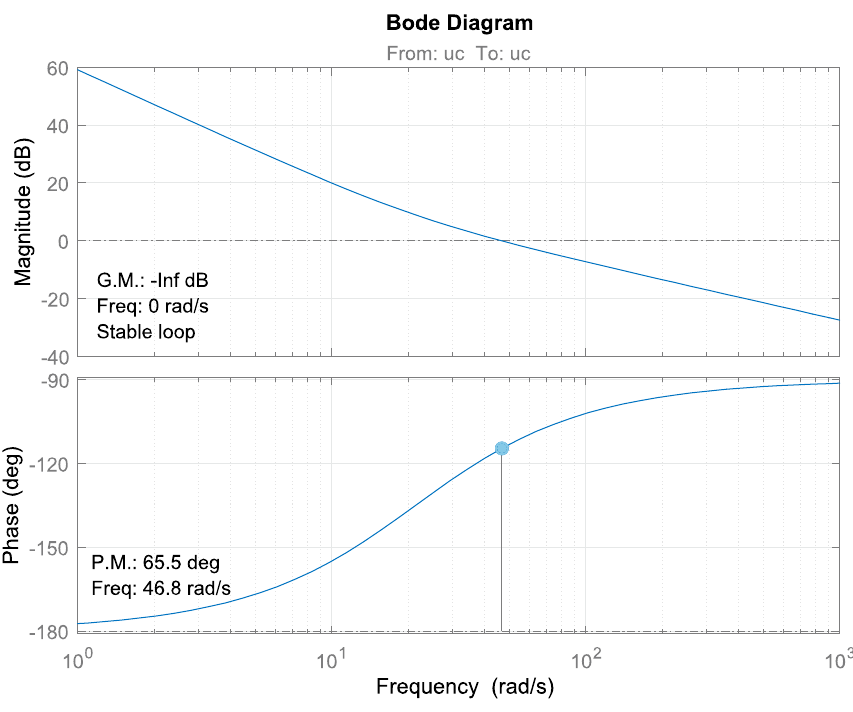
Figure 21. Voltage control loop Bode diagram.